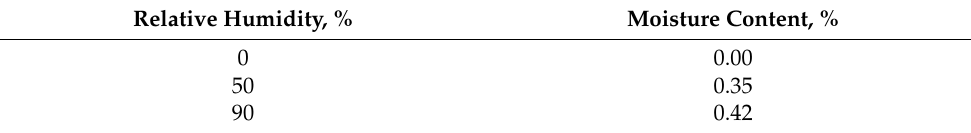
Table 3. Moisture content of the polymer conditioned under different relative humidity. Relative Humidity, %